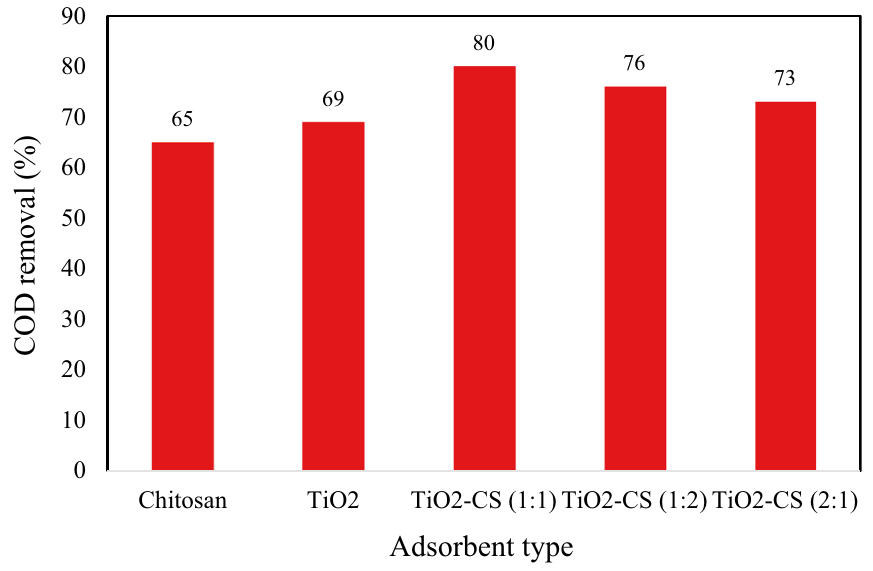
Figure 5. Performance of synthesized adsorbents for COD removal from wastewater (CS: Chitosan).